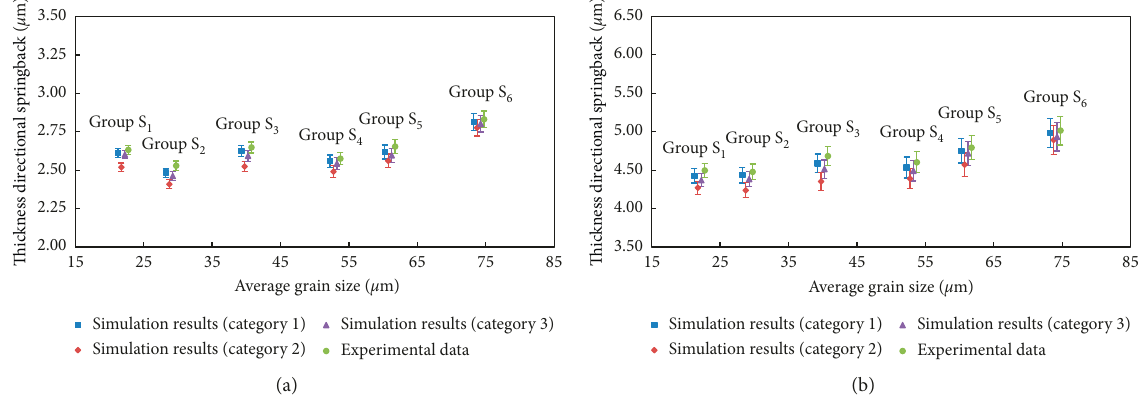
1 –S 6 : (a) 5% reduction; (b) 10%